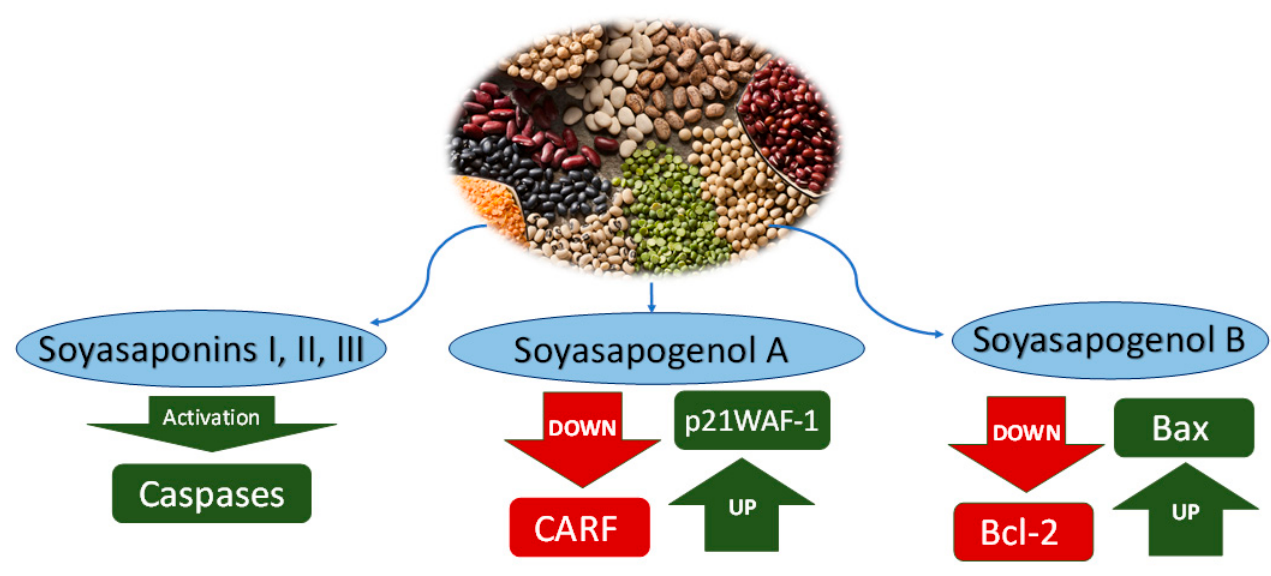
Figure 2. Anticancer mechanisms of saponins from water extract of Leguminosae. Soyasaponins I, II and III activate caspase enzymes. Soyasapogenol A downregulates CARF and upregulates p21WAF-1. Soyasapogenol B downregulates Bcl-2 and upregulates Bax.